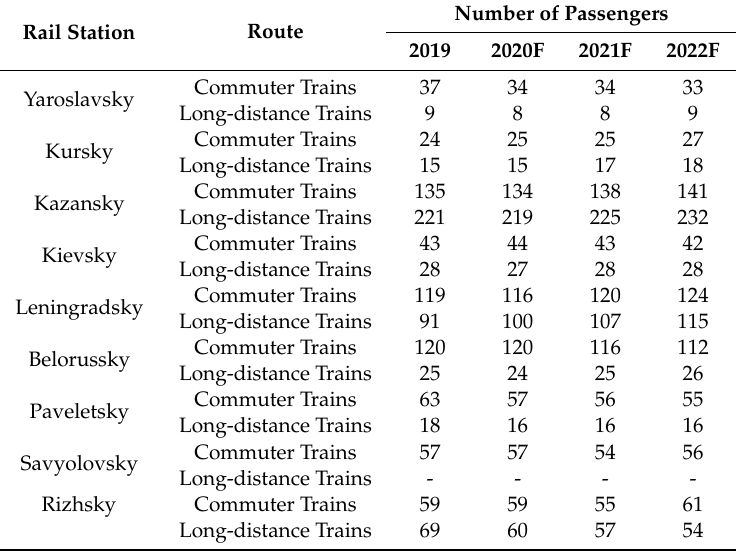
Table 3. Actual (2019) and forecast (2020–2022) passenger flows at the entry groups at Moscow rail stations during rush hours (average number of passengers per 1 min)